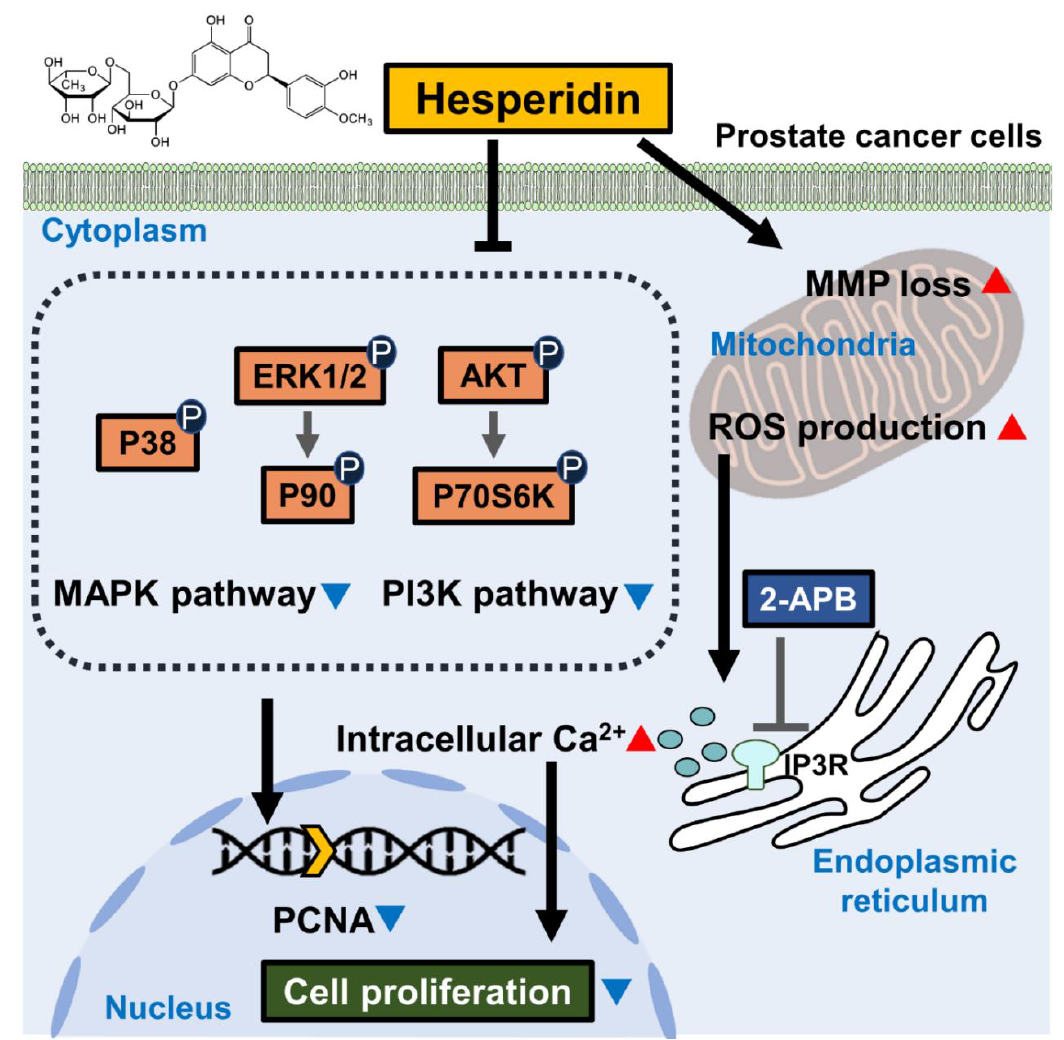
Figure 9. Scheme indicating the mechanism of action of hesperidin in prostate cancer cells. Hesperidin inhibits the PI3K and MAPK signaling pathways in prostate cancer cells. In addition, hesperidin induces the loss of mitochondrial membrane potential (MMP) and promotes reactive oxygen species (ROS) generation. Hesperidin also promotes the levels of Ca 2+ released from the endoplasmic retic- ulum (ER), which is prevented by 2-aminoethyl diphenyl borate (2-APB). Hesperidin-induced phys- iological changes lead to the inhibition of cell proliferation, which is represented by a decrease in PCNA levels in the nucleus of prostate cancer cells.